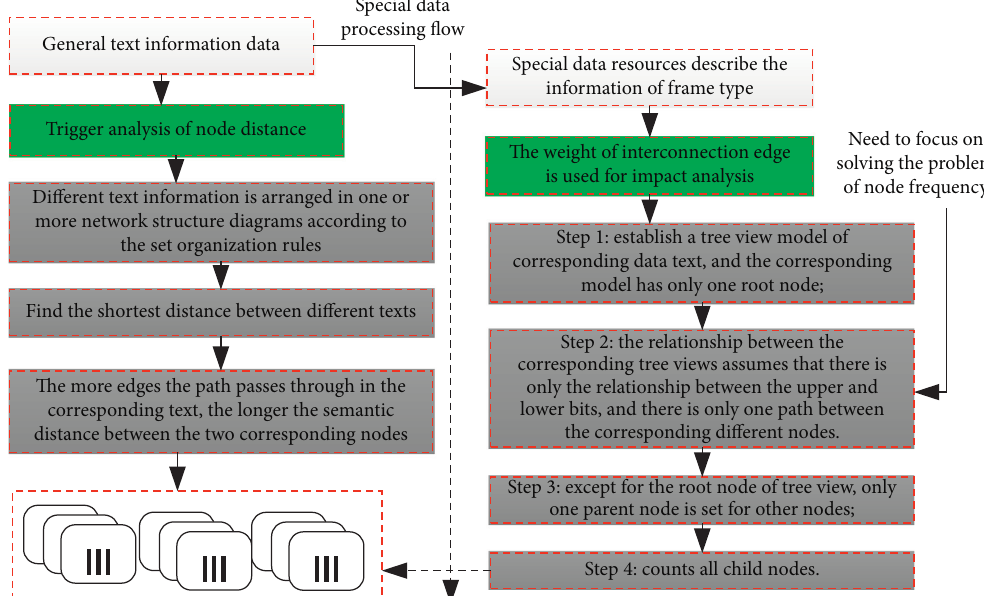
Figure 4: Flow chart of node distance trigger analysis.